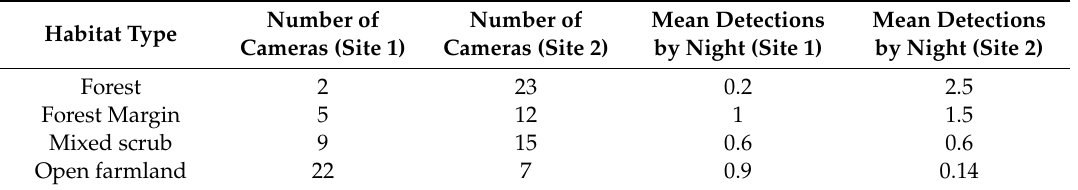
Table 1. Number of cameras and mean nightly cat detections (21 days) per habitat type, for Site 1 and